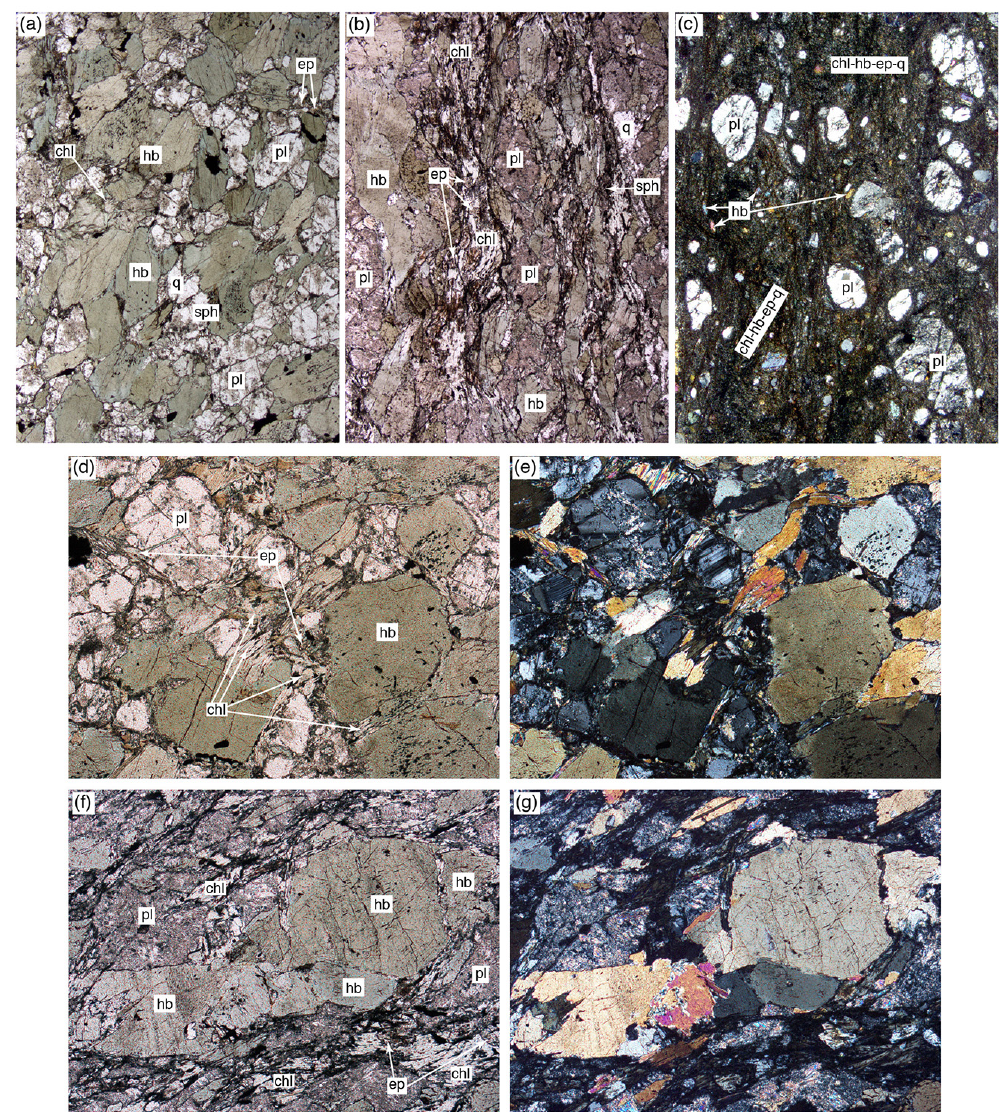
Figure 3. Photomicrographs. (a) Overview of the unsheared texture in KMZ28. Long axis is 4.5mm, plane-polarized light (ppl). (b) KMZ29 showing elongated hornblende grains alternating with chlorite–epidote foliae. Long axis is 4.5mm, ppl. (c) KMZ30 consisting of rounded plagioclase and hornblende porphyroclasts in a fine-grained and mylonitized matrix. Long axis is 4.5mm, cross-polarized light (xpl). Panels (d) and (e) illustrate the largely static breakdown of hornblende to chlorite and epidote with no preferred alignment in KMZ28. Long axis is 2.2mm and (d) is in ppl and (e) in xpl. Panels (f) and (g) illustrate subgrain formation and disaggregation of hornblende parallel to the foliation in KMZ29. Long axis is 2.2mm and (f) is in ppl and (g) in